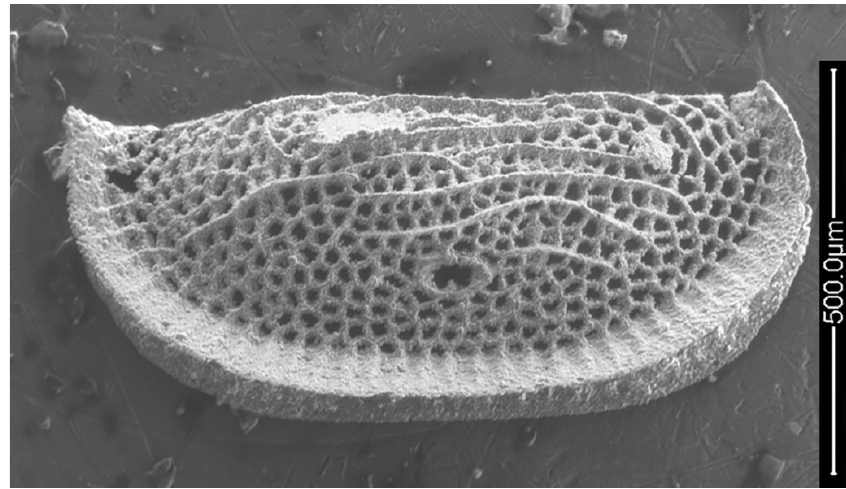
Figure 2. Kirkbya panamintensis nov. sp., right valve, lateral view. Holotype, IGM 5011(1). Scanning electron micrograph (secondary electrons). Lower Carboniferous (Lower Mississippian), Lower Tin Mountain Formation. Scale bar = 500 microns.